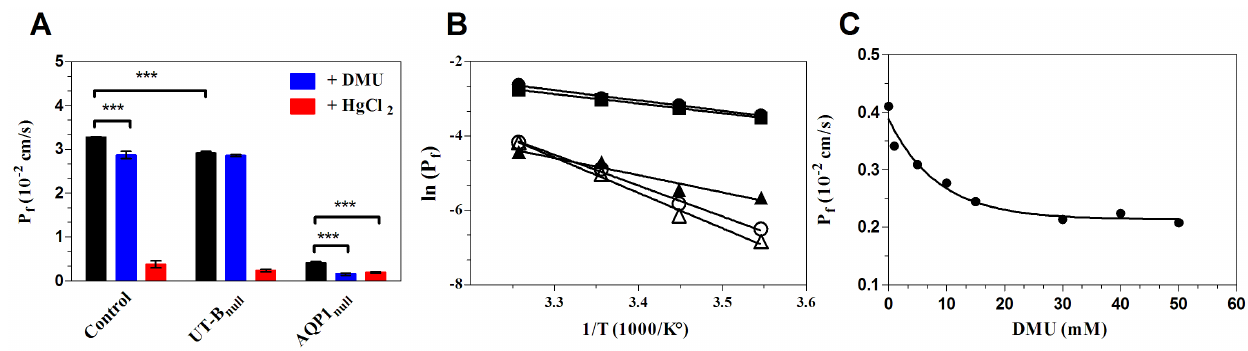
Figure 1. Osmotic water permeability of RBCs. (A) Coefficients of osmotic water permeability (P f ) at 15 u C in the absence or the presence of inhibitors (Blue, 15 mM DMU; red, 0.5 mM HgCl 2 ). Three experiments for each individual were averaged and the means of the rate constants (k, s 2 1 ) for 3 controls, 3 UT-B null and 2 AQP1 null were reported ( 6 SD). Statistical significances between the P f of DMU and/or HgCl 2 -treated versus untreated RBCs (control and AQP1 null ) were determined by paired t tests. Statistical significances between the P f of control versus UT-B null RBCs were determined by unpaired t tests. *** indicates a significant difference (p , 0.0001). (B) Arrhenius activation energies Ea (which are related to the slope of the plot) of osmotic water permeation across RBC membranes (filled circles, normal; squares, UT-B null ; filled triangles, AQP1 null ; open triangles, AQP1 null + HgCl 2 ; open circles, AQP1 null + DMU). (C) Coefficients of osmotic water permeability for control RBCs incubated with increasing concentrations of DMU and submitted to a 400 mosm/kgH 2 O mannitol osmotic gradient of at 15 u